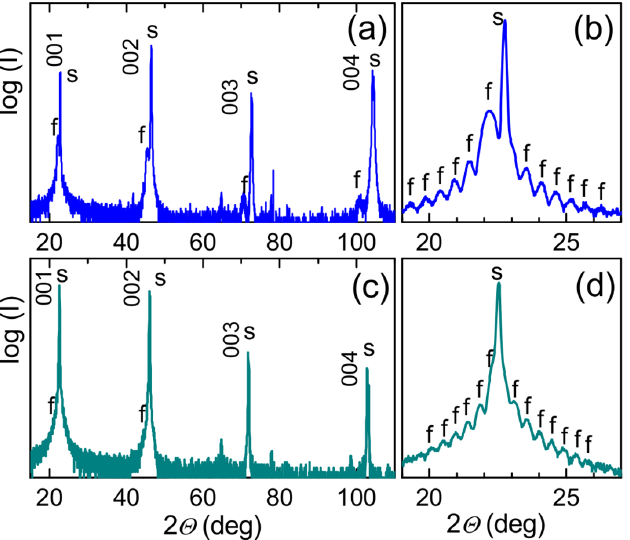
Fig 2. Θ -2 Θ x-ray diffraction patterns in the KNNO films on (a,b) SrTiO 3 (001) and (c,d) DyScO 3 (011) substrates. Diffractions from the substrates and films are marked by s and f , correspondingly. Panels (b,d) show scans around (002)